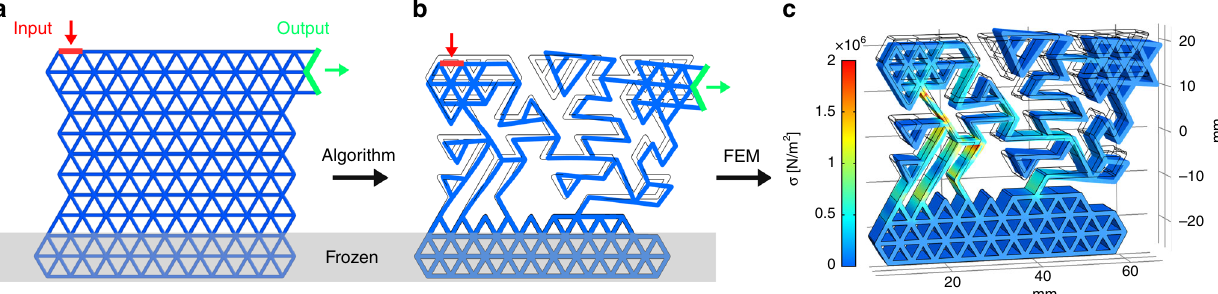
Fig. 1 Schematic of automatic structure generation. a The initial triangular lattice con fi guration R IS . b The optimized structure obtained with DEM and its modeled response upon input displacement. c The same structure movement simulated by FEM. The colormap displays the Von Mises stress.